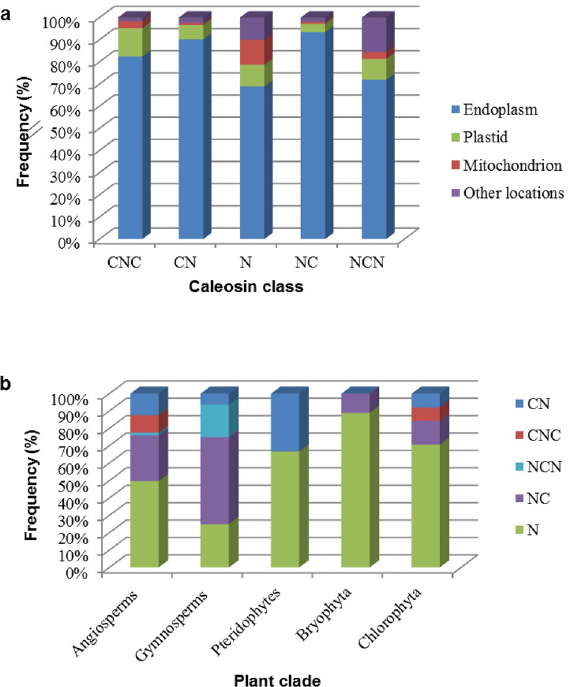
Figure 2. ( a ) The frequency of subcellular locations for each caleosin class. ( b ) The percentage of each caleosin class in the major clades of plants. The caleosin classes have been named based on the order of non-cytoplasmic (N) and cytoplasmic (C) domains.